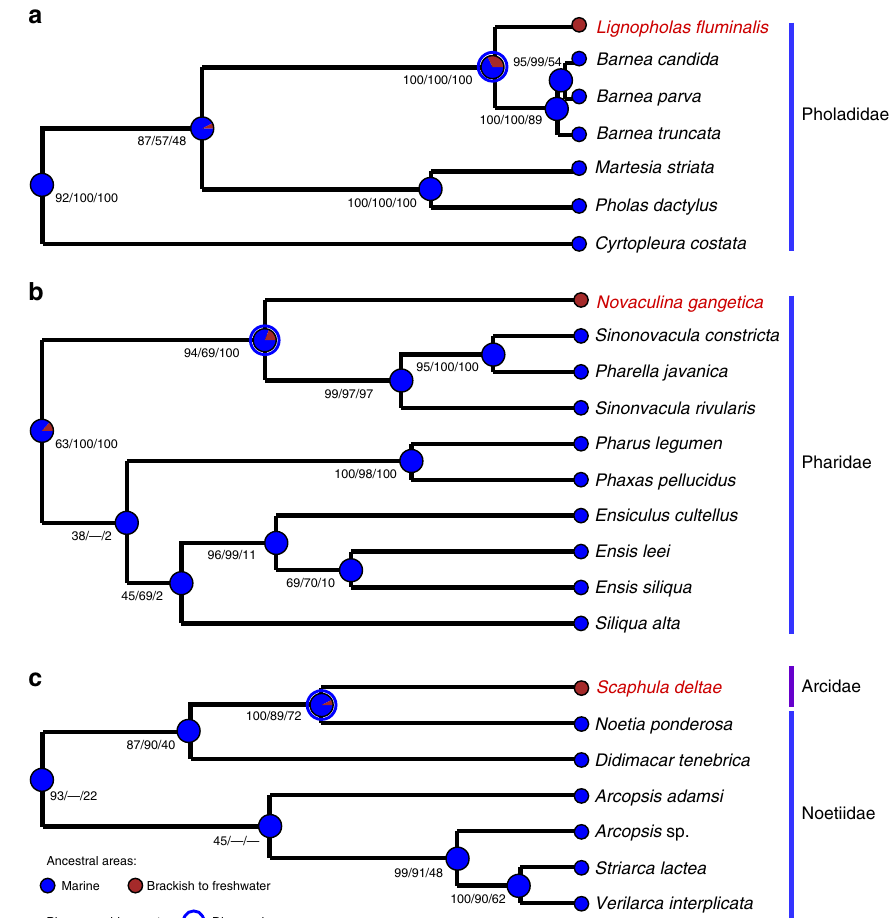
Fig. 5 Ultrametric Bayesian (BEAST 2) phylogenies showing the primary marine origin of rock-boring and nestling bivalve species from the bioerosion site in the Kaladan River, including a Lignopholas fl uminalis , Pholadidae ( 18S rRNA + 28S rRNA , 3033 bp), b Novaculina gangetica , Pharidae ( COI + 16S rRNA + 28S rRNA , 2602 bp), and b Scaphula deltae , Arcidae ( 28S rRNA + 18S rRNA , 2450 bp, full tree includes 44 taxa but the other clade of Arcidae is not shown here: see Supplementary Fig. 2). Black numbers near nodes are BPP values inferred from BEAST/BPP values inferred from MrBayes/BS values inferred from RAxML ( “—” indicates a topological difference). Pie chaps on the nodes indicate the probabilities of certain ancestral areas with respect to combined results under three different models (S-DIVA, DEC, and S-DEC) inferred from RASP v.